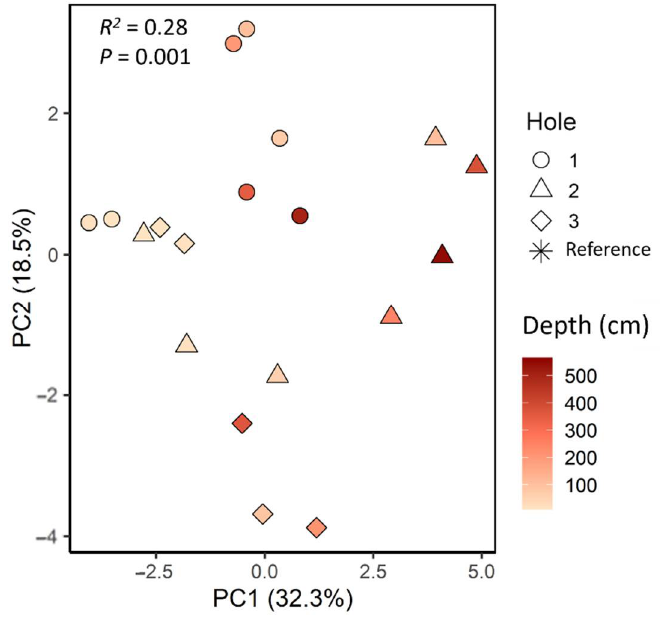
Figure 4. PCA plots showing differences in soil chemical properties at QR mill with changing stockpile depth. PC1 accounts for 32.9% and PC2 accounts for 18.5% of variation observed between soil